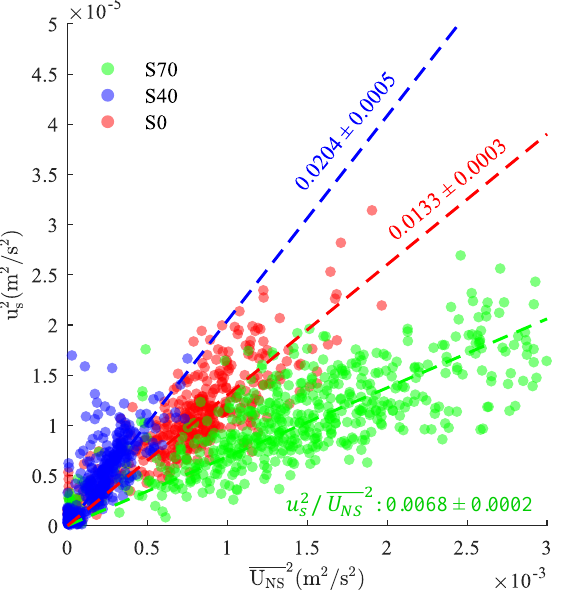
Figure 6. Squared turbulent velocity scales ( u 2 s ) versus nearshore current speeds ( U NS 2 ) as observed at the S70 (green), S40 (blue), and S0 (red) sample sites. Best fit lines for each data set (dashed lines) are shown for reference, with labels representing the 95% CI on best fit slope.